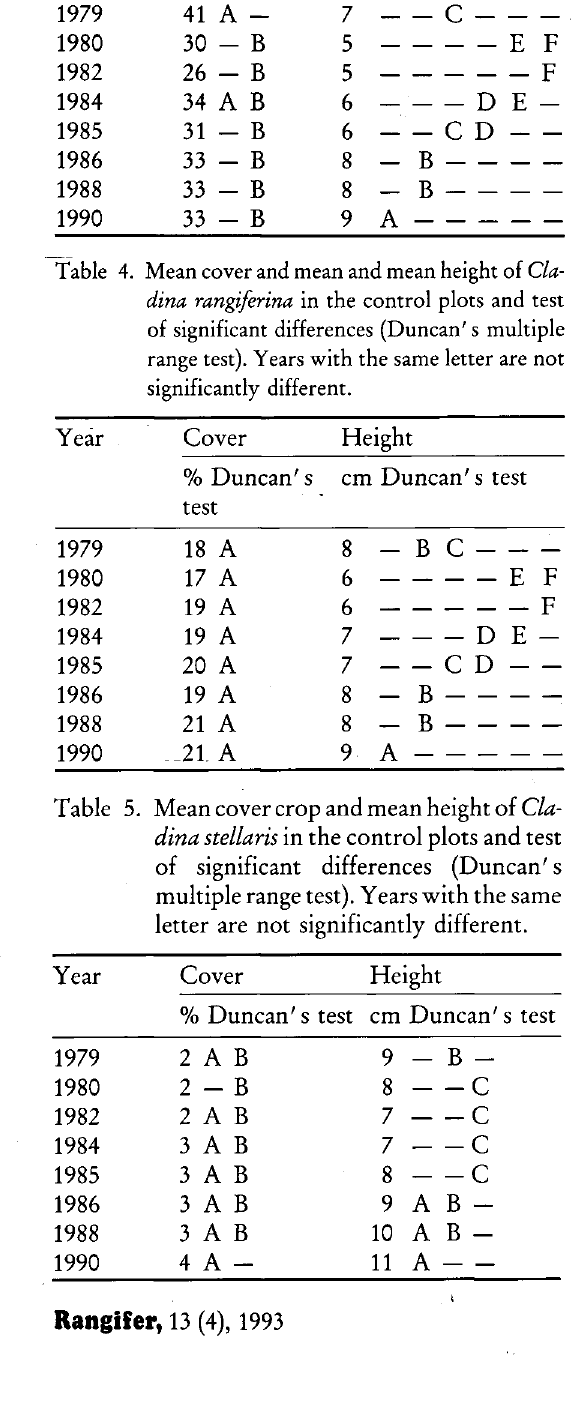
Table 3. Mean cover, mean standing crop and mean height of Cladina arbuscula in the control plots and test of significant differences (Dun can's multiple range test). Years with the same letter are not significantly different.